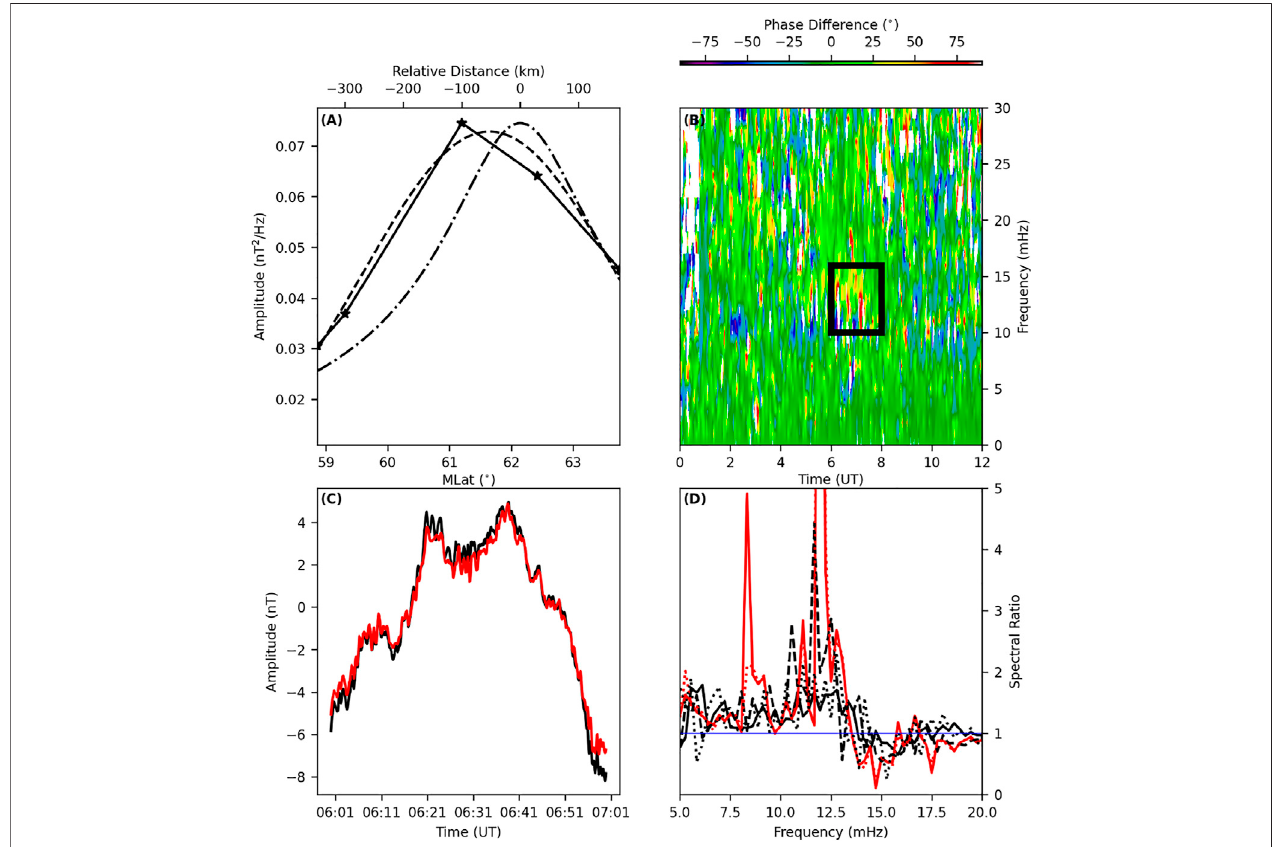
FIGURE 7 | (A) Latitudinal spectral amplitude curve fi ts; Linear piece-wise (solid, stars at station locations), Gaussian (dashed) and FLR amplitude ( Eq. 3 , dash- dotted) versus MLat/km, (B) Dynamic cross phase between IVA-SOD, (C) Time series of the IVA (black) and SOD (red) magnetometer stations, and (D) Spectral amplitude ratio for the boxcar (black, dotted), Hann (red, dashed), Hamming (red, solid), exponential taper (black, solid), and multi-taper (black, dashed) FFT window processing for the IVA-SOD magnetometer data for the 19 June 2015 interval.